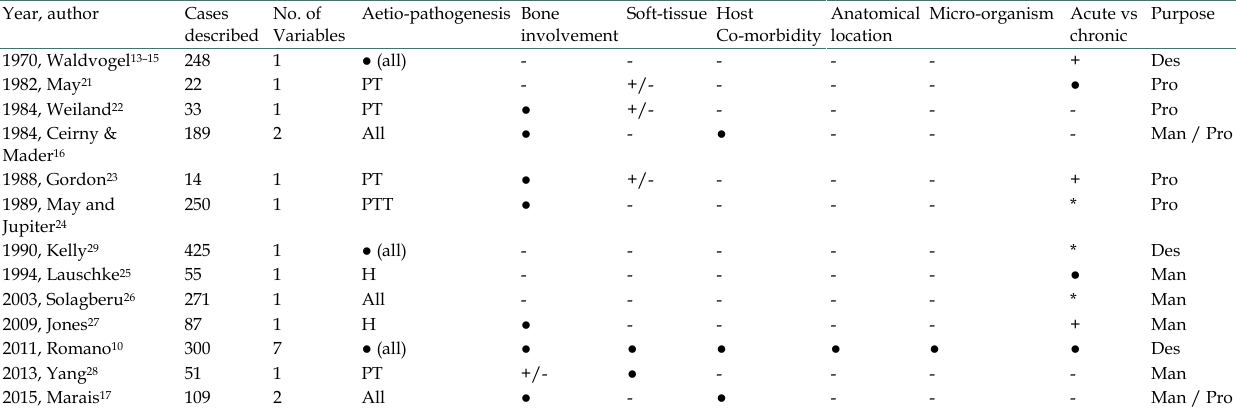
Table 1. The 13 included classification systems and the variables each that were described in each. Year,